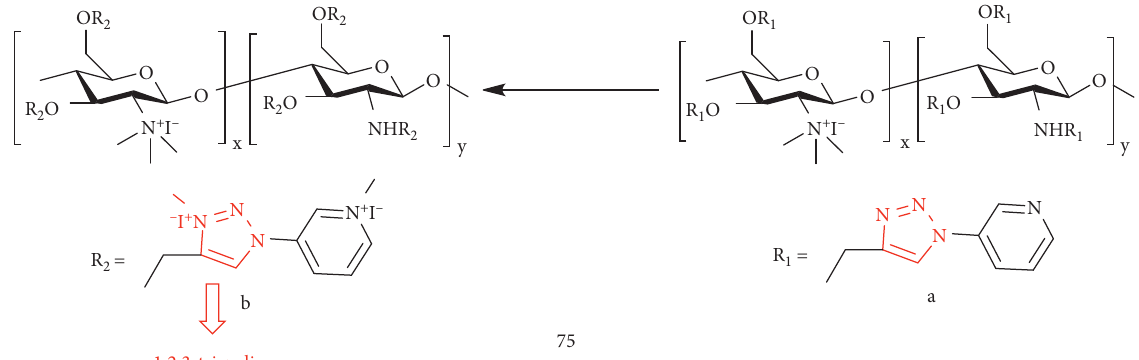
Figure 28: Chemical structure of novel cationic chitosan derivations bearing 1,2,3-triazolium and pyridinium.